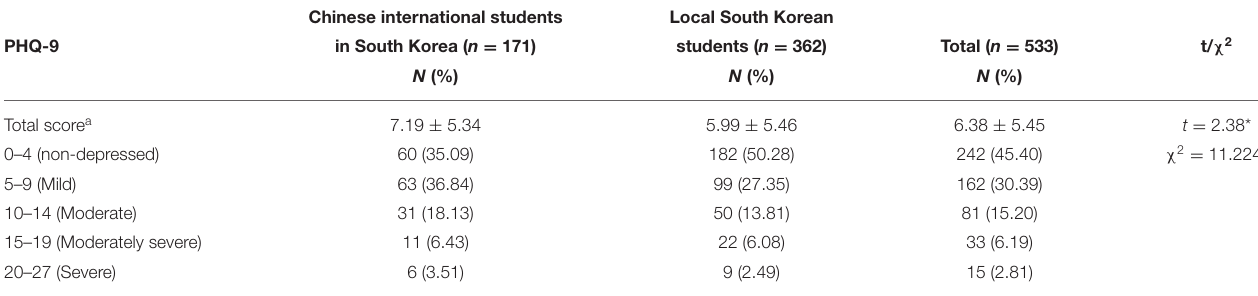
TABLE 4 | Difference in depressive symptoms between the Chinese international students and local Korean